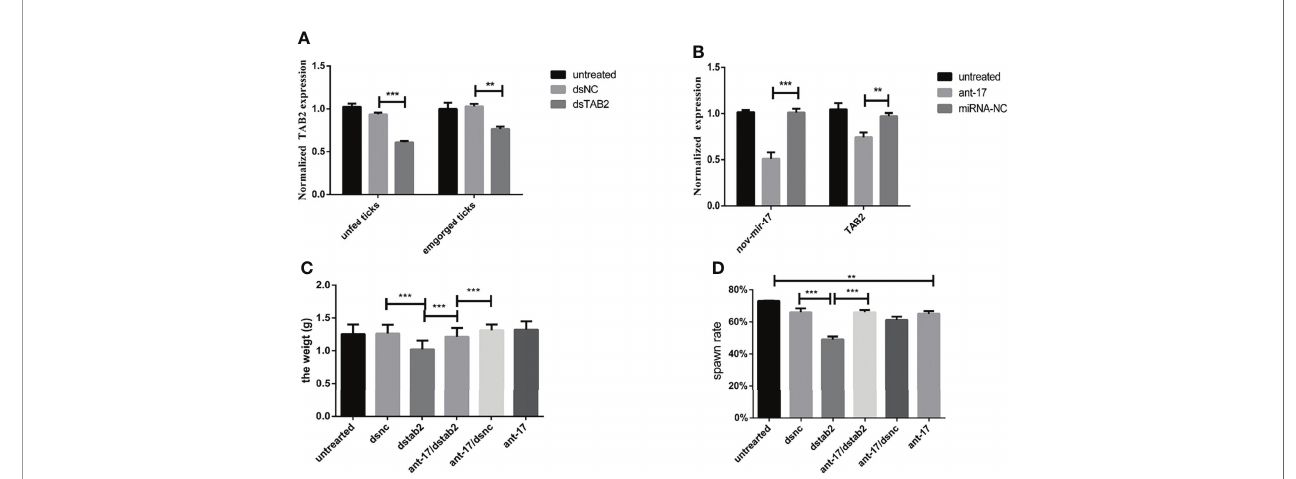
FIGURE 6 | (A) The expression of HasTAB2 in unfed and engorged female ticks was tested 24 h after RNA silencing. (B) The expression of Has TAB2 and nov-miR- 17 in engorged female ticks was tested 24 h after miRNA silencing. (C) Number of days during which ticks were monitored in phenotype rescue experiments. (D) Spawn rate of the ticks in the phenotype rescue experiments. The data are presented as the means ± SEMs of triplicate samples. * P < 0.05, ** P < 0.01, *** P < 0.001.